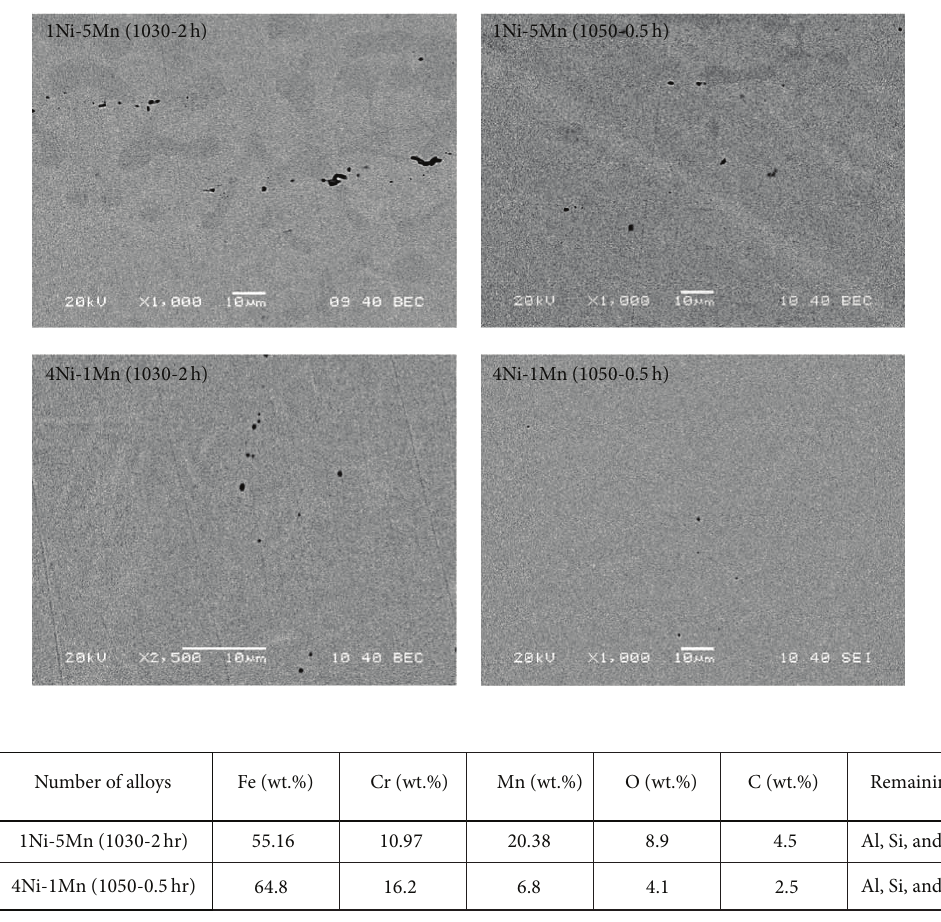
Figure 2: SEM/EDS micrographs of the four stainless steel alloys after solution annealing at different temperatures.